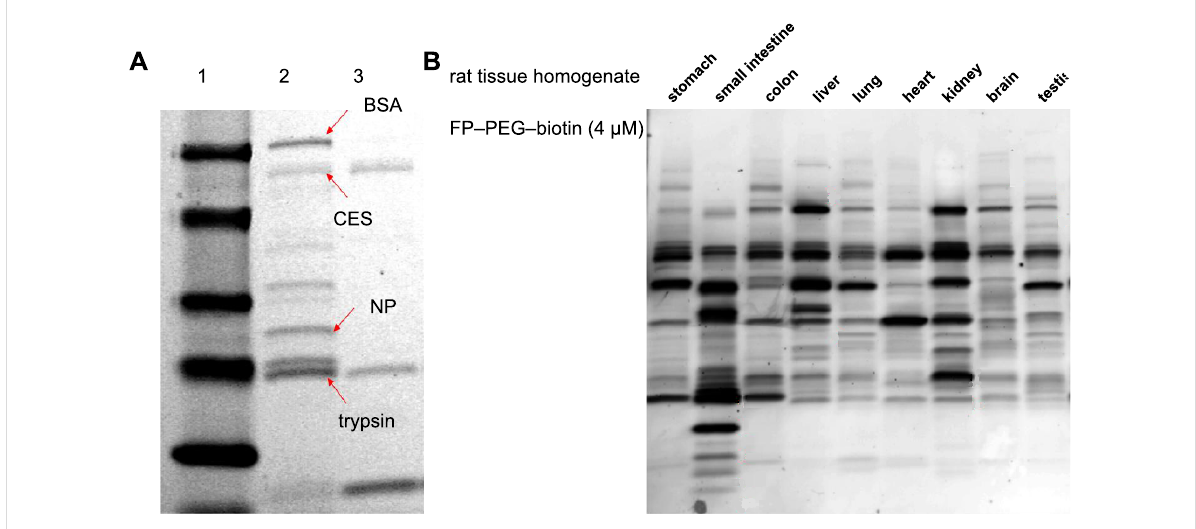
Figure 2: Labeling and affinity isolation of serine hydrolases by FP–PEG–biotin 1 . (A) Lane 1: Protein standard. Lane 2: Mixture of BSA, pCES, NP, trypsin before purification. Lane 3: Purification results. (B) Rat tissue homogenates were prepared in 50 mM Tris buffer (pH 8.0) as 1 mg/mL samples from each tissue and incubated with FP–PEG–biotin 1 (4 μ M) at room temperature for 1 h. Samples were quenched with 5× sample loading buffer, heated at 85 °C for 5 min, and separated by SDS-PAGE. Protein samples were transferred to a PVDF membrane, blotted by streptavidin alkaline phosphatase, and visualized by incubation with ECF substrate.